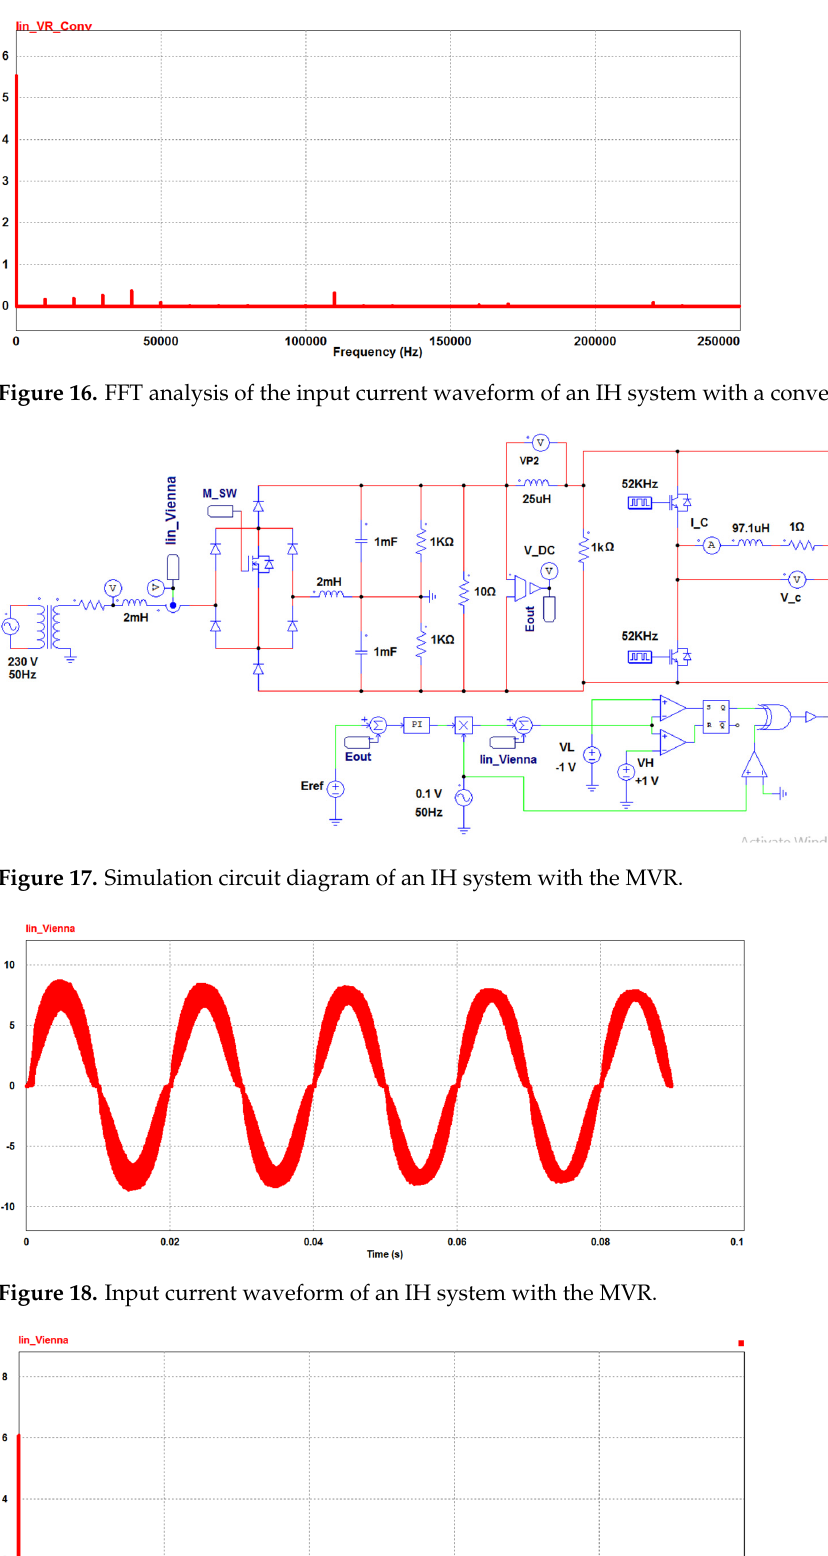
Figure 15. Input current waveform of an IH system with a conventional VR.